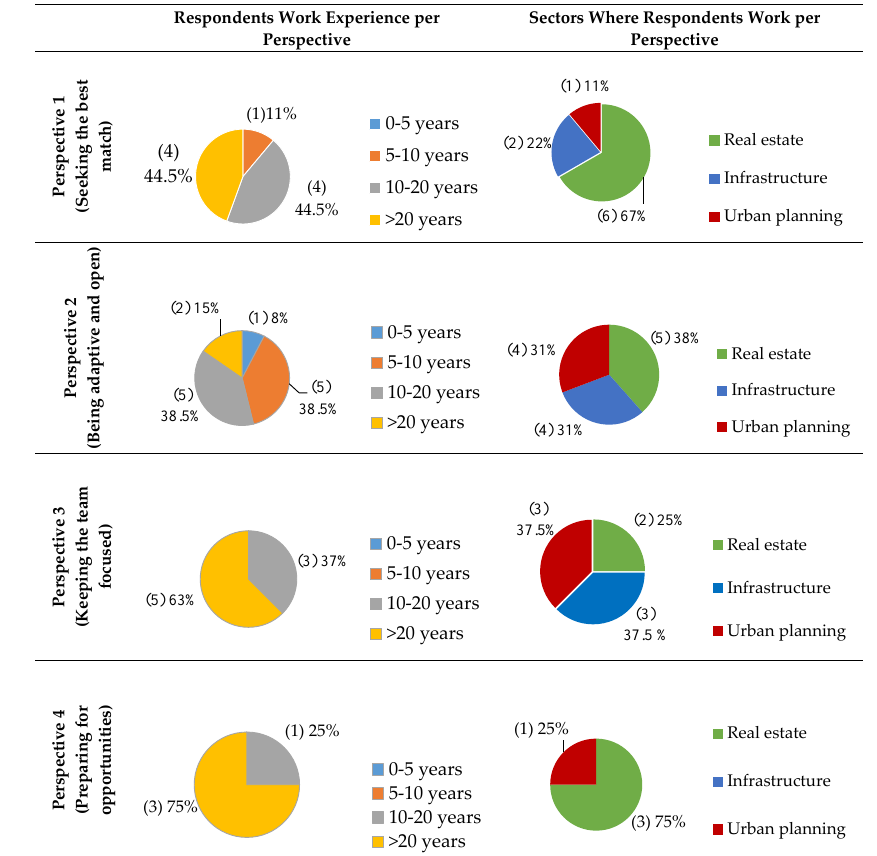
Table A3. Demography of the respondents per perspective.